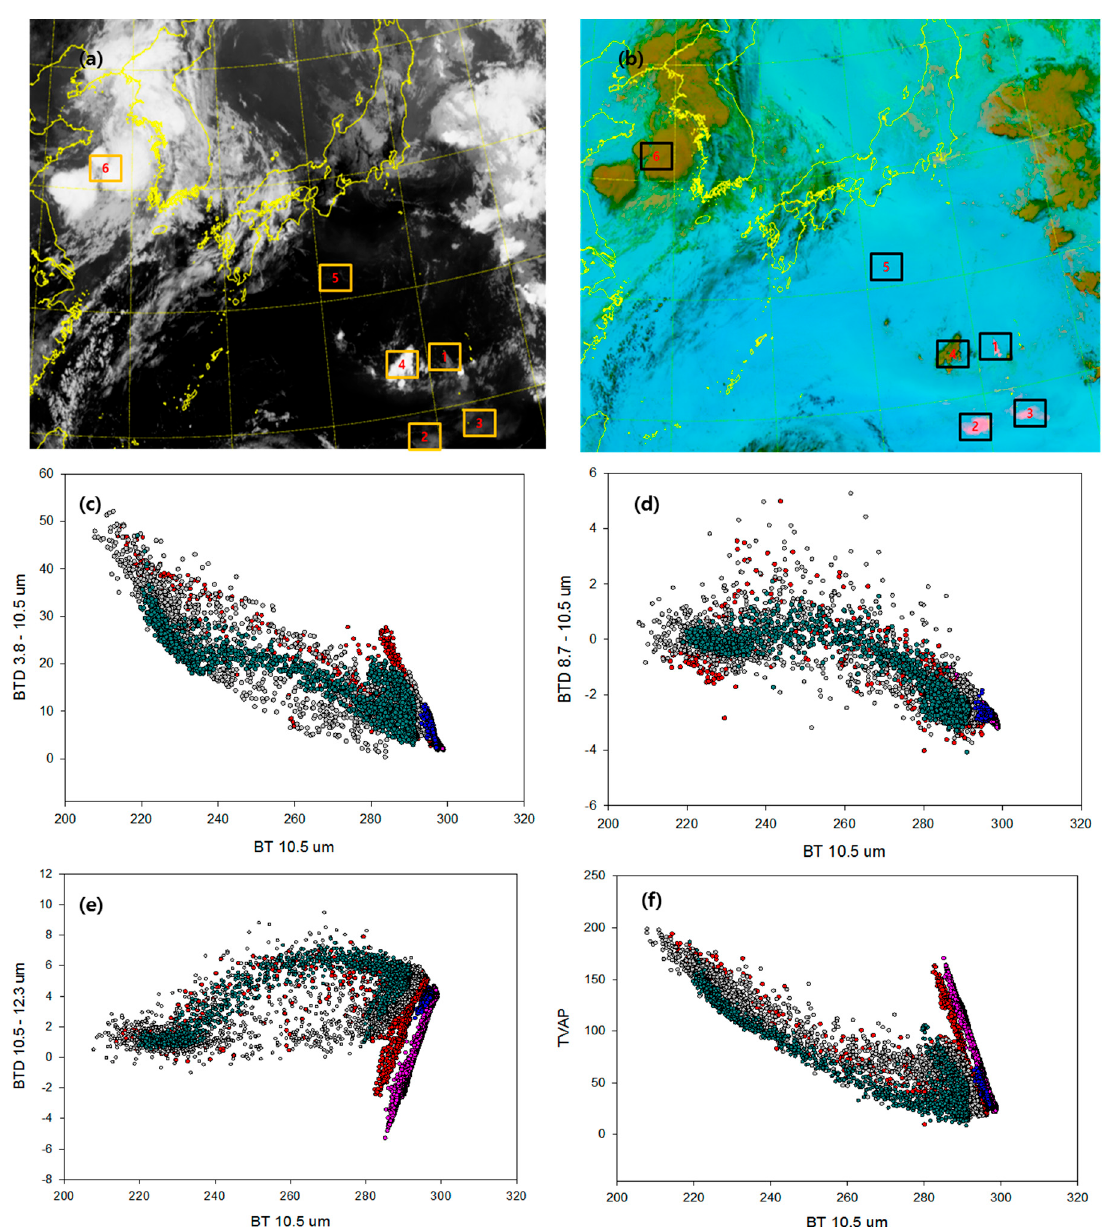
Figure 8. Interpretation of the scene for the Nishinoshima volcano divided by the colors of GK-2A Ash RGB (1 August 2020, 00:00 UTC). Images represent ( a ) GK-2A/AMI BT 10.5 μ m and ( b ) GK-2A Ash RGB (area 1: ash (red), area 2: ash (hot pink), area 3: ash (pink), area 4: convective cloud (emerald), area 5: clean (blue), area 6: ice-cloud (gray)). Scatter plot between 10.5 μ m and each threshold test using ( c ) BTD 3.8–10.5 μ m , ( d ) BTD 8.7–10.5 μ m, ( e ) BTD 10.5–12.3 μ m and ( f ) TVAP divided by the colors of GK-2A Ash RGB.